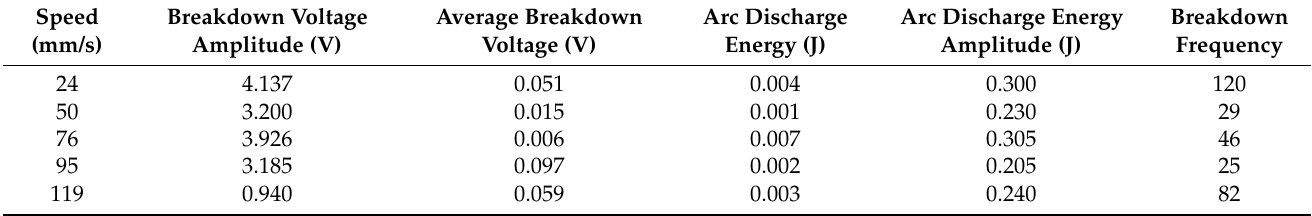
Table 7. Electrical breakdown of the contact couple in insulating oil after 120 min